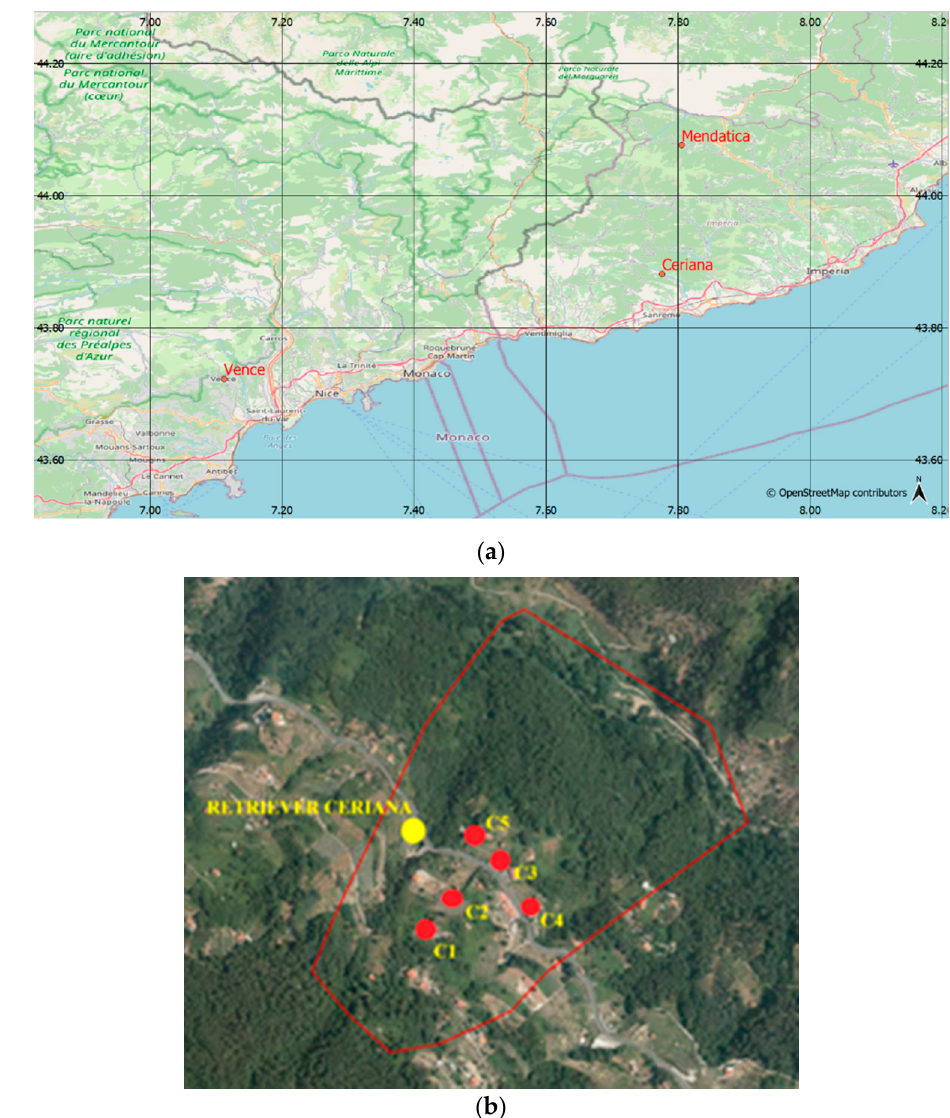
Figure 11. ( a ) Location of Ceriana, Mendatica and Vence (map in WGS84); ( b ) Installed monitoring network. The nodes (red dots) are denoted by